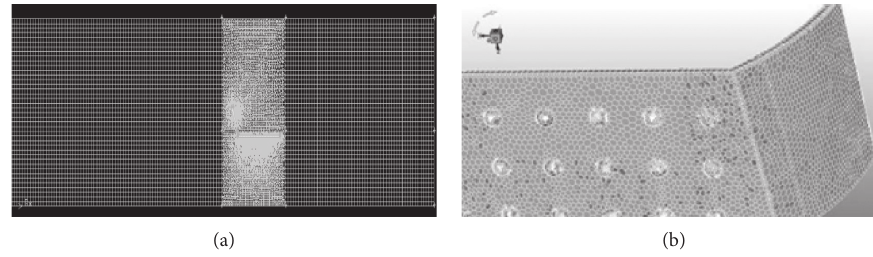
Figure 1: Grid division. (a) Mesh generation. (b) Convex hull local mesh refinement.